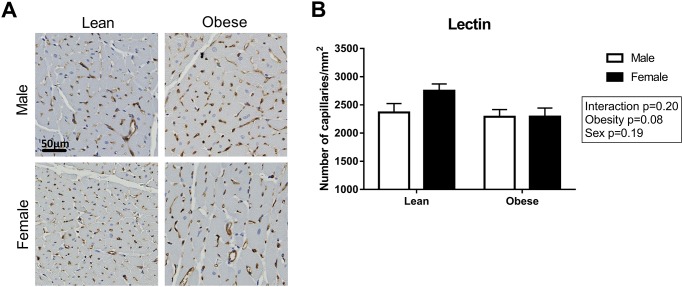
No microvascular changes were found in the ZSF1 rats.A) Representative images and B) quantification of the microvasculature stained with Lectin. N = 4-7/group.